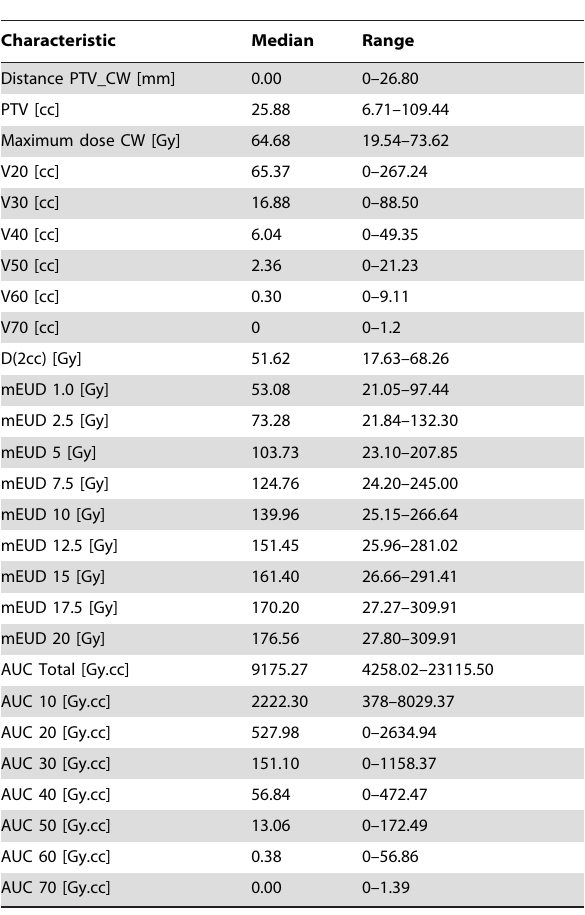
Table 3. Tumor Characteristics and Dosimetry